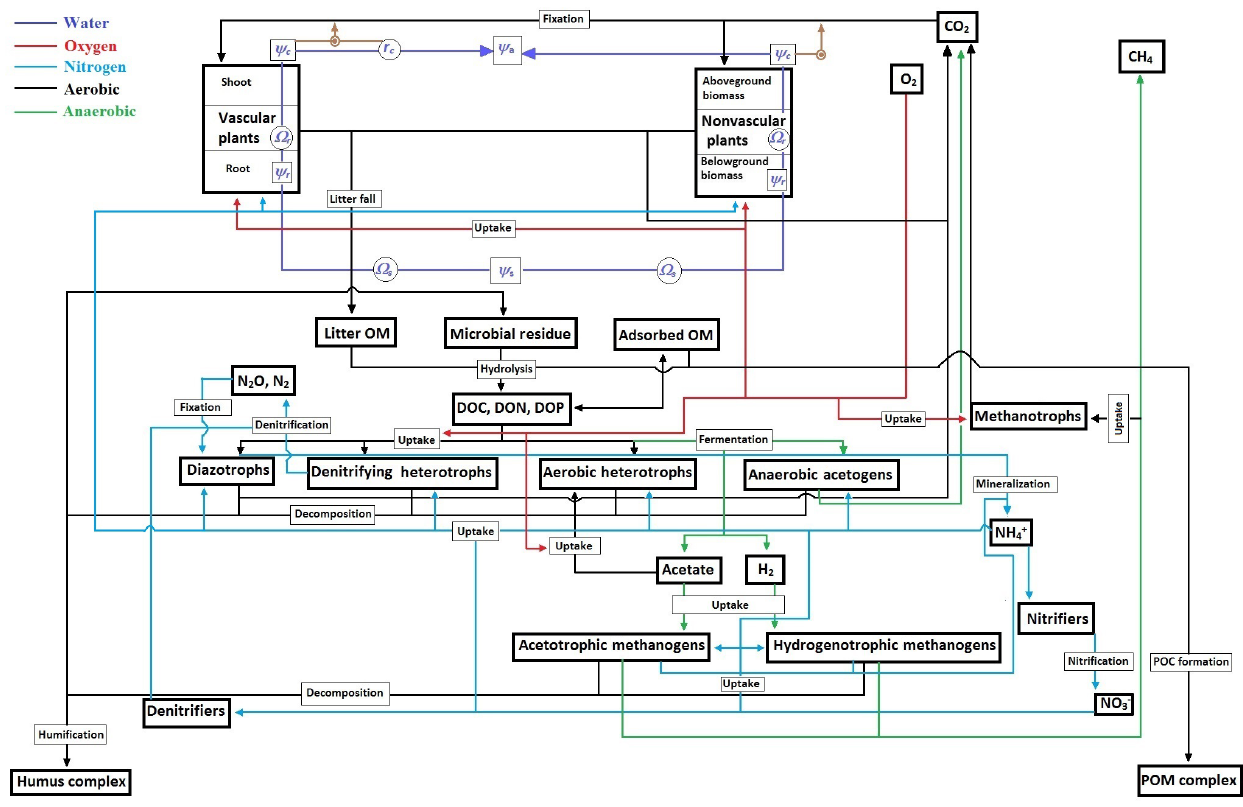
Figure 1. Schematic diagram of ecosys algorithms representing coupled key eco-physiological and biogeochemical (aerobic and anaerobic) processes and plant water relations of a typical boreal fen peatland ecosystem that are affected by WTD fluctuation. (cid:57) a , (cid:57) c and (cid:57) s : at- mospheric, canopy and soil water potentials; (cid:57) r : vascular root or nonvascular belowground water potential; r c : canopy stomatal resistance (1/ g c ); (cid:127) s : soil hydraulic resistance; (cid:127) r : hydraulic resistance to water flow through plants; OM: organic matter; DOC, DON, DOP: